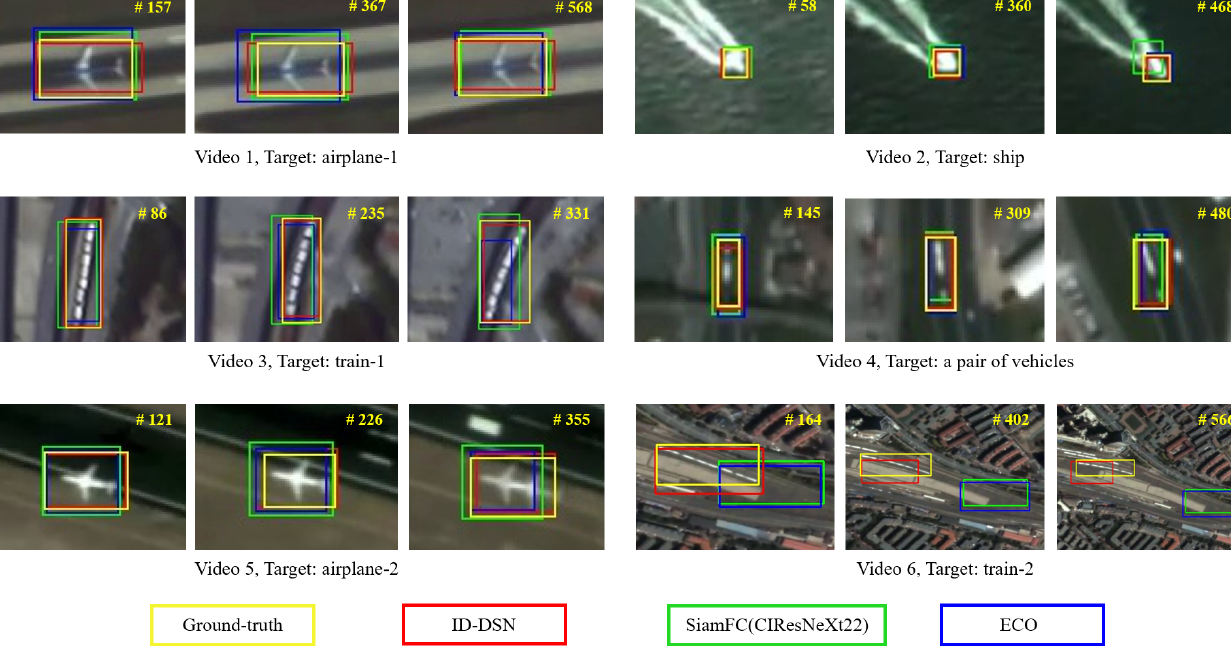
Figure 9. The visualized tracking results of ID-DSN, Fully-Convolutional Siamese Networks (SiamFC) (CIResNeXt22; CIR = Cropping-Inside Residual) and Efficient Convolution Operator (ECO) trackers with corresponding ground-truth. The yellow # at the top right of the image represents the video frame